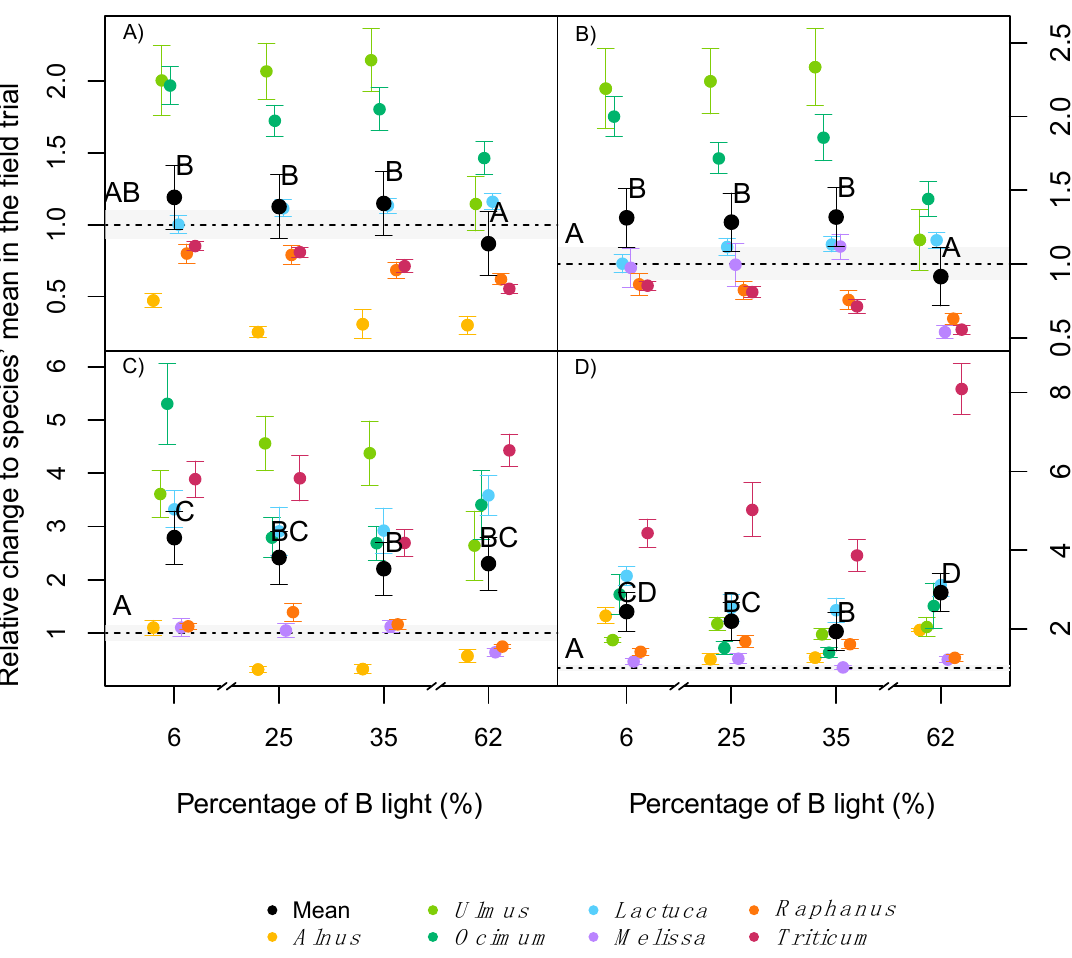
Figure 3. Fold change on: leaves ( A ), shoot ( B ), roots ( C ) and root to shoot ratio ( D ), as dry weight relative to the average value of the field trial (dotted line). Coloured dots are the average of each species in both experiments runs ( n = 18), the black dots are the average values across all 7 species ( n = 126). Error bars indicate the standard errors. The grey area corresponds to the standard error of the field trial. Di ff erent letters indicate statistical di ff erence between groups with experiment replicate and species as a random effect.